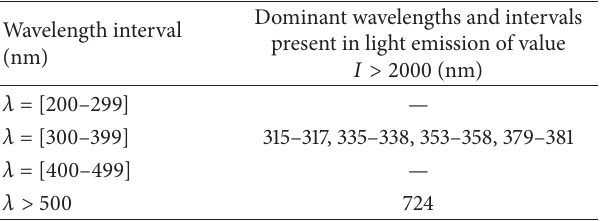
Table 4: Dominant wavelengths present in light emission of value 𝐼 > 2000